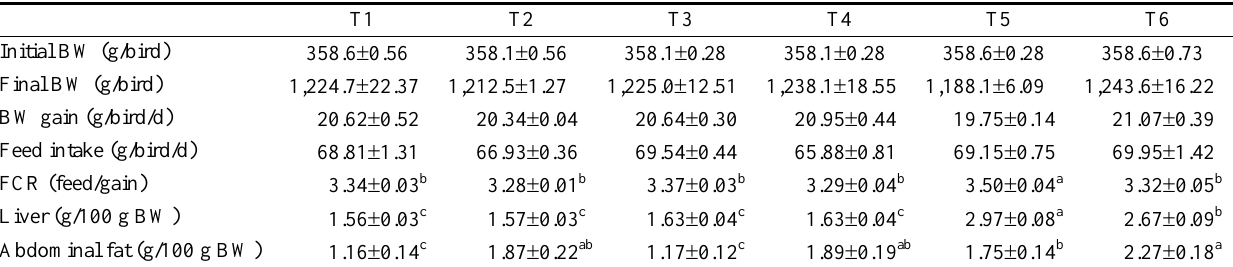
Table 3. Effects of various treatments for inducing fatty liver hemorrhagic syndrome on growth performance and relative weights of organs in immature laying-type male chicks at ages 4 to 10 wks 1